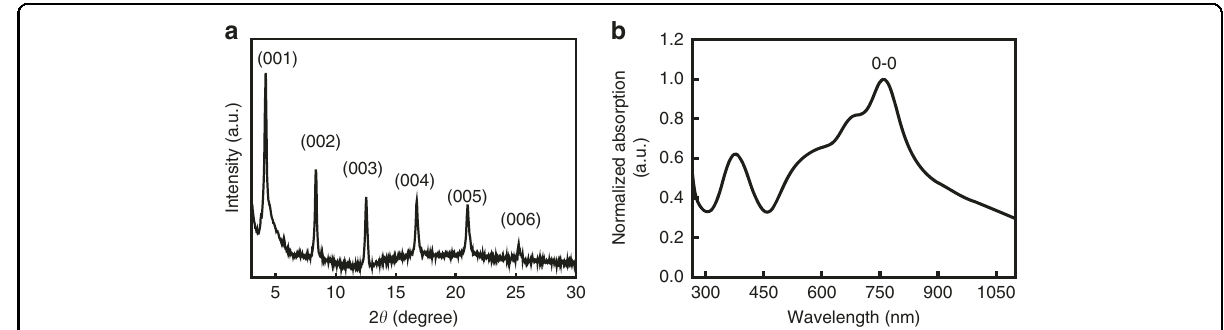
Fig. 2 The characterization of the assembled TDPPQ nanosheet. a The XRD pattern of the TDPPQ nanosheets fabricated from 0.1 mg/mL TDPPQ solution. b The absorption spectrum of the TDPPQ nanosheets dispersed in